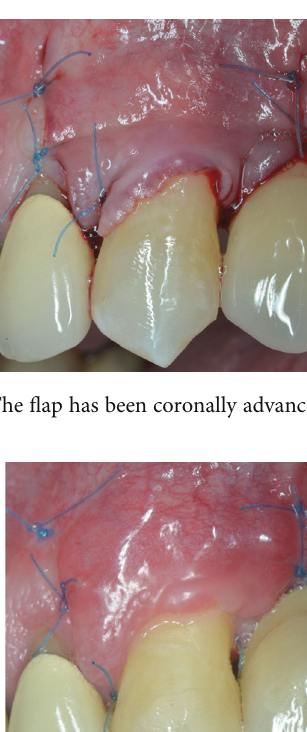
Figure 8: An epithelial-connective tissue graft is harvested. The height is 4 mm, and the length corresponds to the root width plus 3mm.